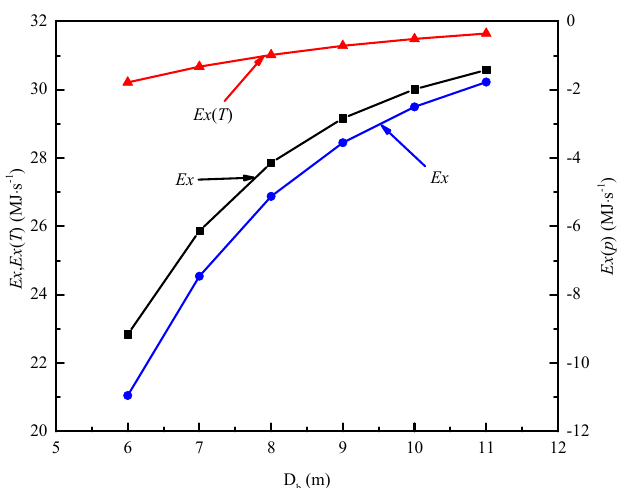
Figure 12. Effects of the diameter of the sinter bed on enthalpy exergy Ex , temperature exergy Ex ( T ), and pressure exergy Ex ( p ).